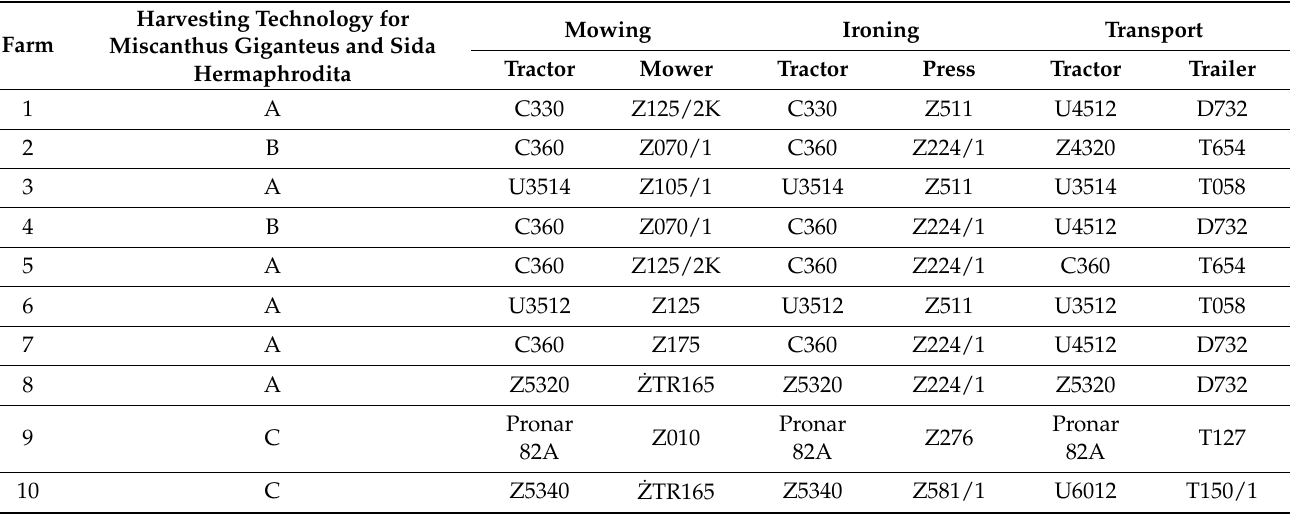
Table 3. Miscanthus giganteus and mullein harvesting technology and machinery used in the surveyed agricultural